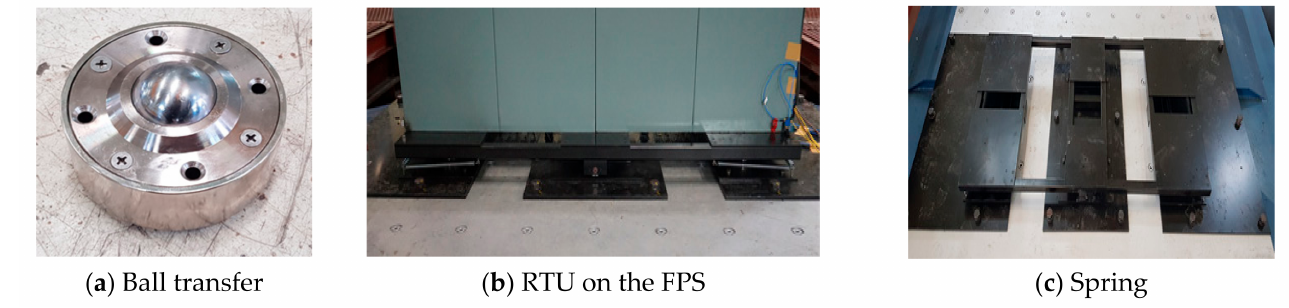
Figure 2. Non-overturn seismic isolator on the shaking table.